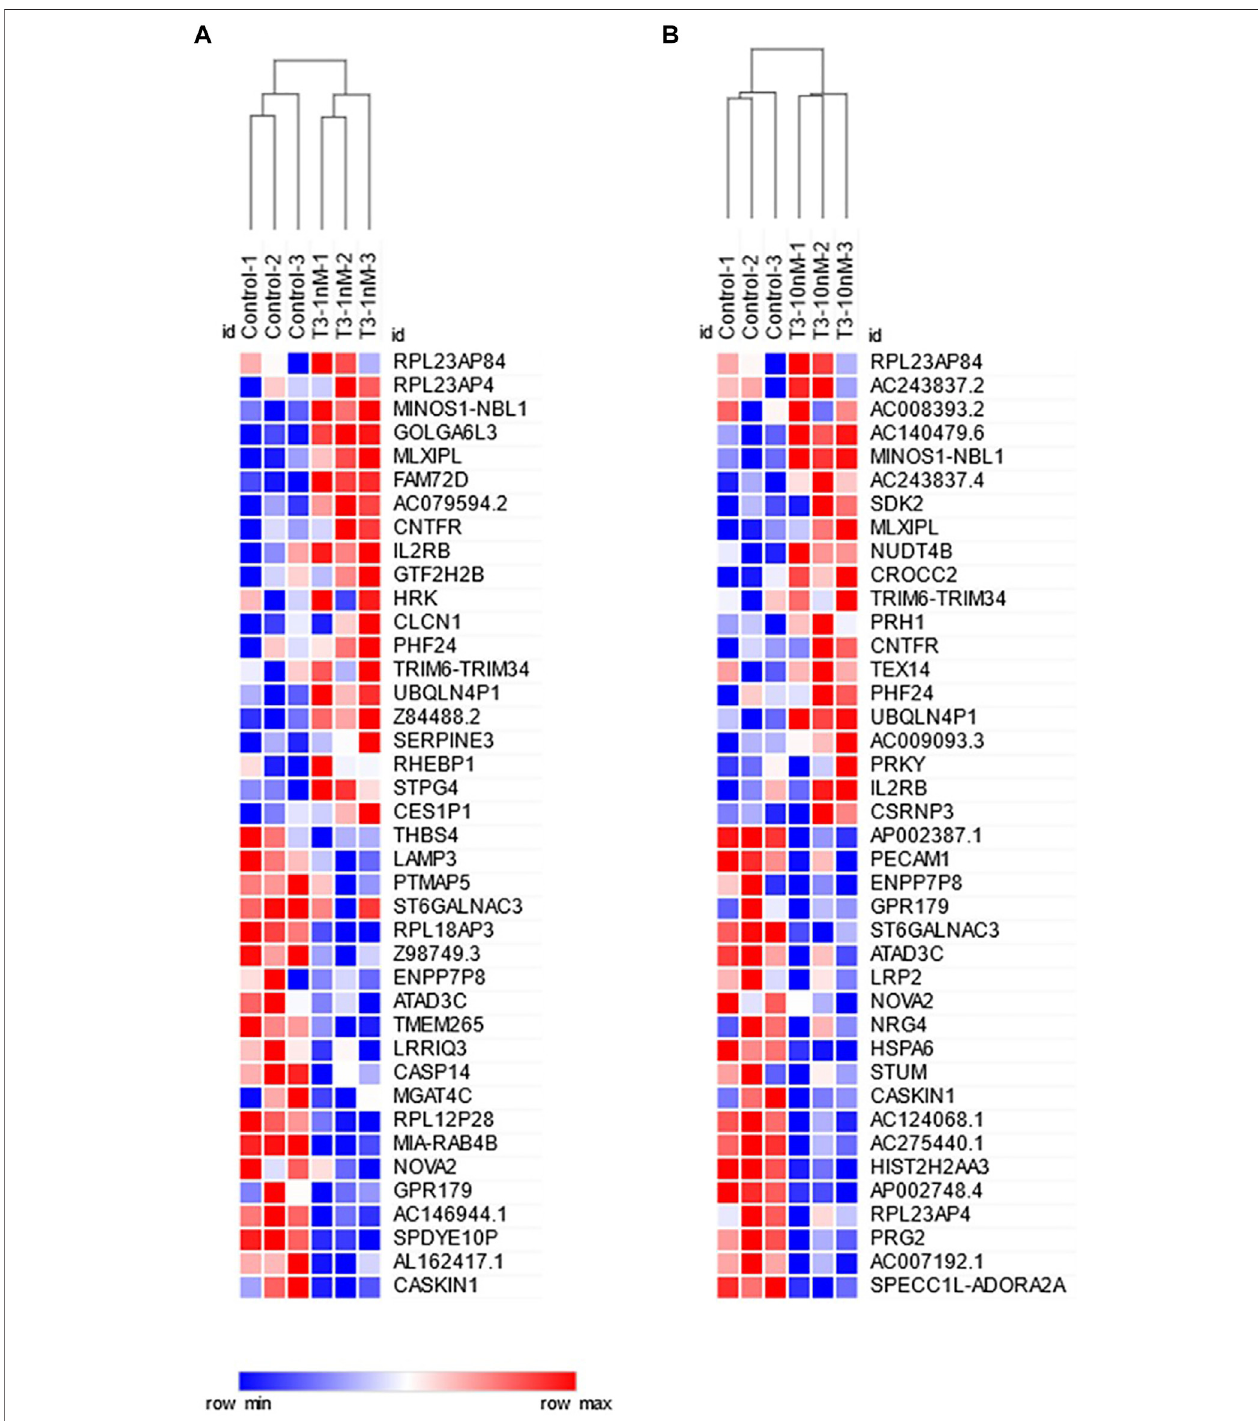
FIGURE 2 | Heatmaps showing the 20 most upregulated (upper half) and 20 most downregulated (lower half) genes for (A) 1 nm T3 and (B) 10 nm T3. Samples (columns) and genes (rows) are hierarchically clustered by mean Euclidean distance.